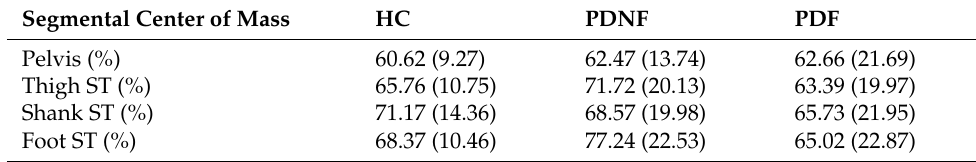
Table 6. Onset of segmental movements at gait initiation. Data are shown as mean (standard devia- tion). Time of movement onset of each segmental center of mass was expressed as the percentage with respect to total gait initiation duration (i.e., from the onset of the anticipatory postural adjustments to the heel contact of the swing foot) and compared across groups (Dunn’s test, no difference was significant after Bonferroni correction for multiple comparisons). Abbreviations: HC, healthy controls; PDF, Parkinson’s disease with freezing of gait; PDNF, Parkinson’s disease with no freezing of gait; ST: stance limb; SW: swing